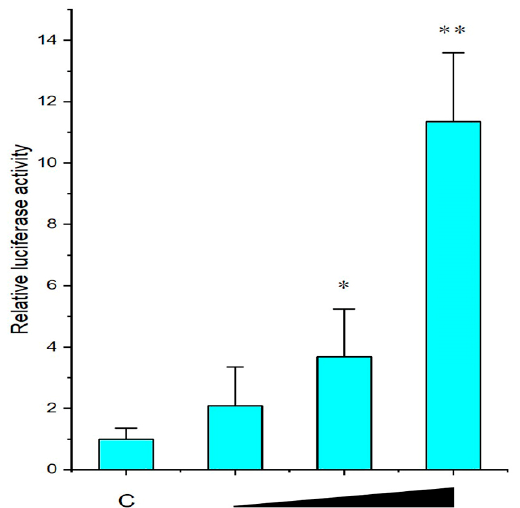
Figure 4. The activation of NF- κ B reporter by Mc IL-17-3. The recombinant vector p EGFP- Mc IL- 17-3 in three concentrations (0.1, 0.5, and 1.0 µ g/well) was cotransfected into HEK293 cells using Lipo6000 TM for 24 h. The relative luciferase activities were calculated by normalizing to the pRL- TK value. The experimental results were expressed as fold changes by comparing the luciferase activities of recombinant vector-induced cells with those of empty vector-induced cells at the same concentration. Each value was shown as mean ± SD ( n = 3), and bars with an asterisk symbol were significantly different (* p < 0.05, ** p <